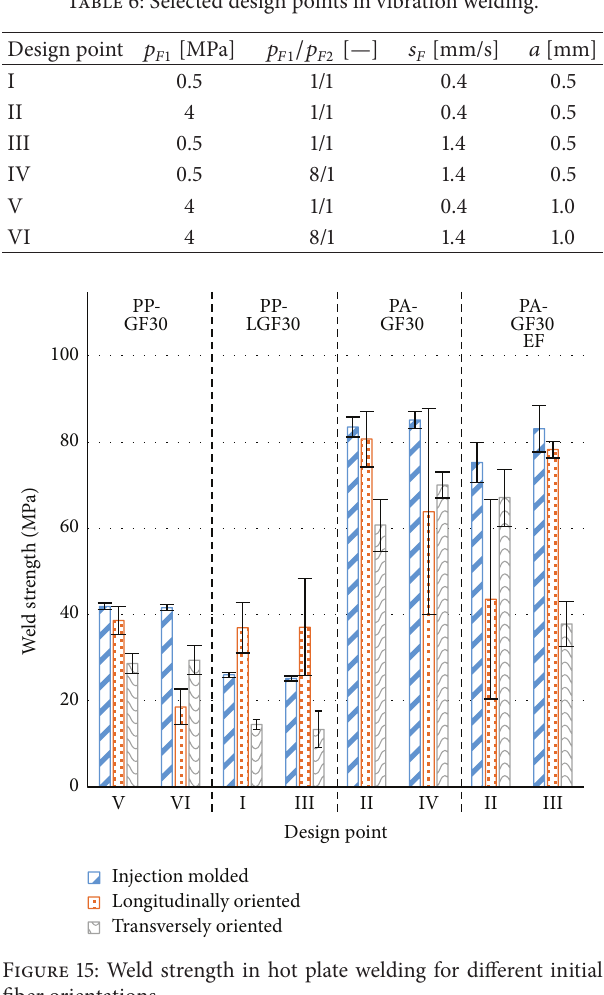
Table 6: Selected design points in vibration welding.